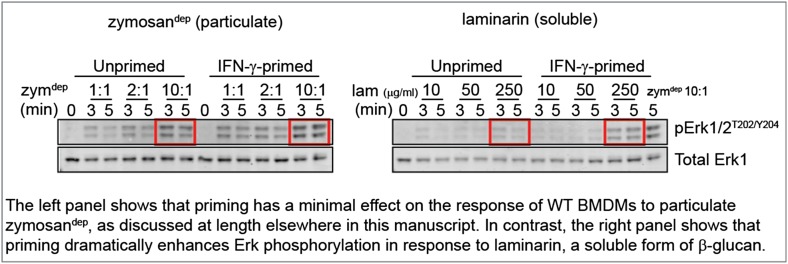
DOI:
http://dx.doi.org/10.7554/eLife.09183.030